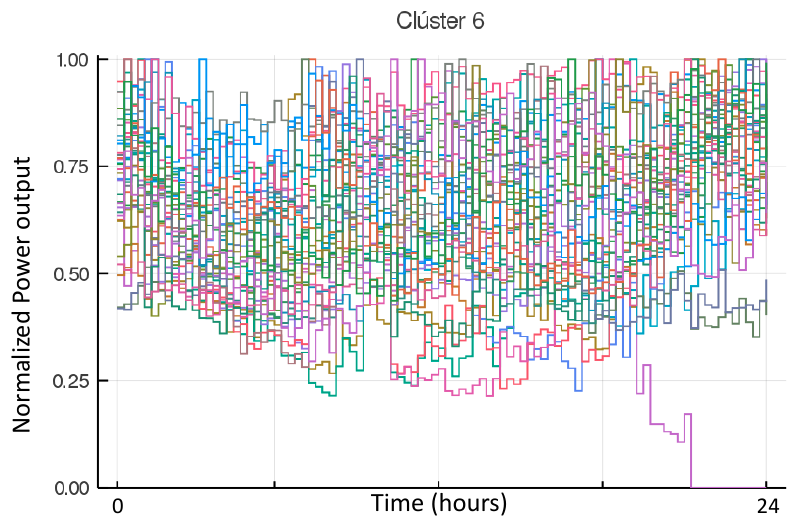
Figure 11. Data of 362 actual distribution customers from Santiago, Chile. Cluster 6.